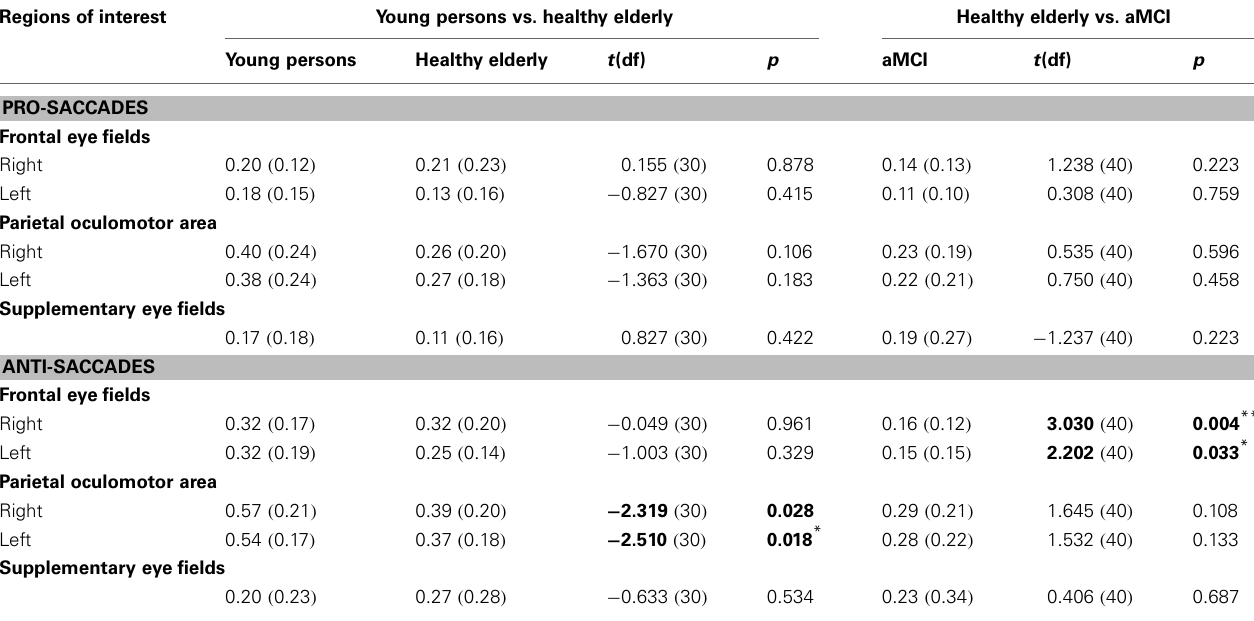
Table 4 | Results of regions of interest analysis in young persons, healthy elderly and aMCI patients (BOLD response as percent signal change within ROI across all